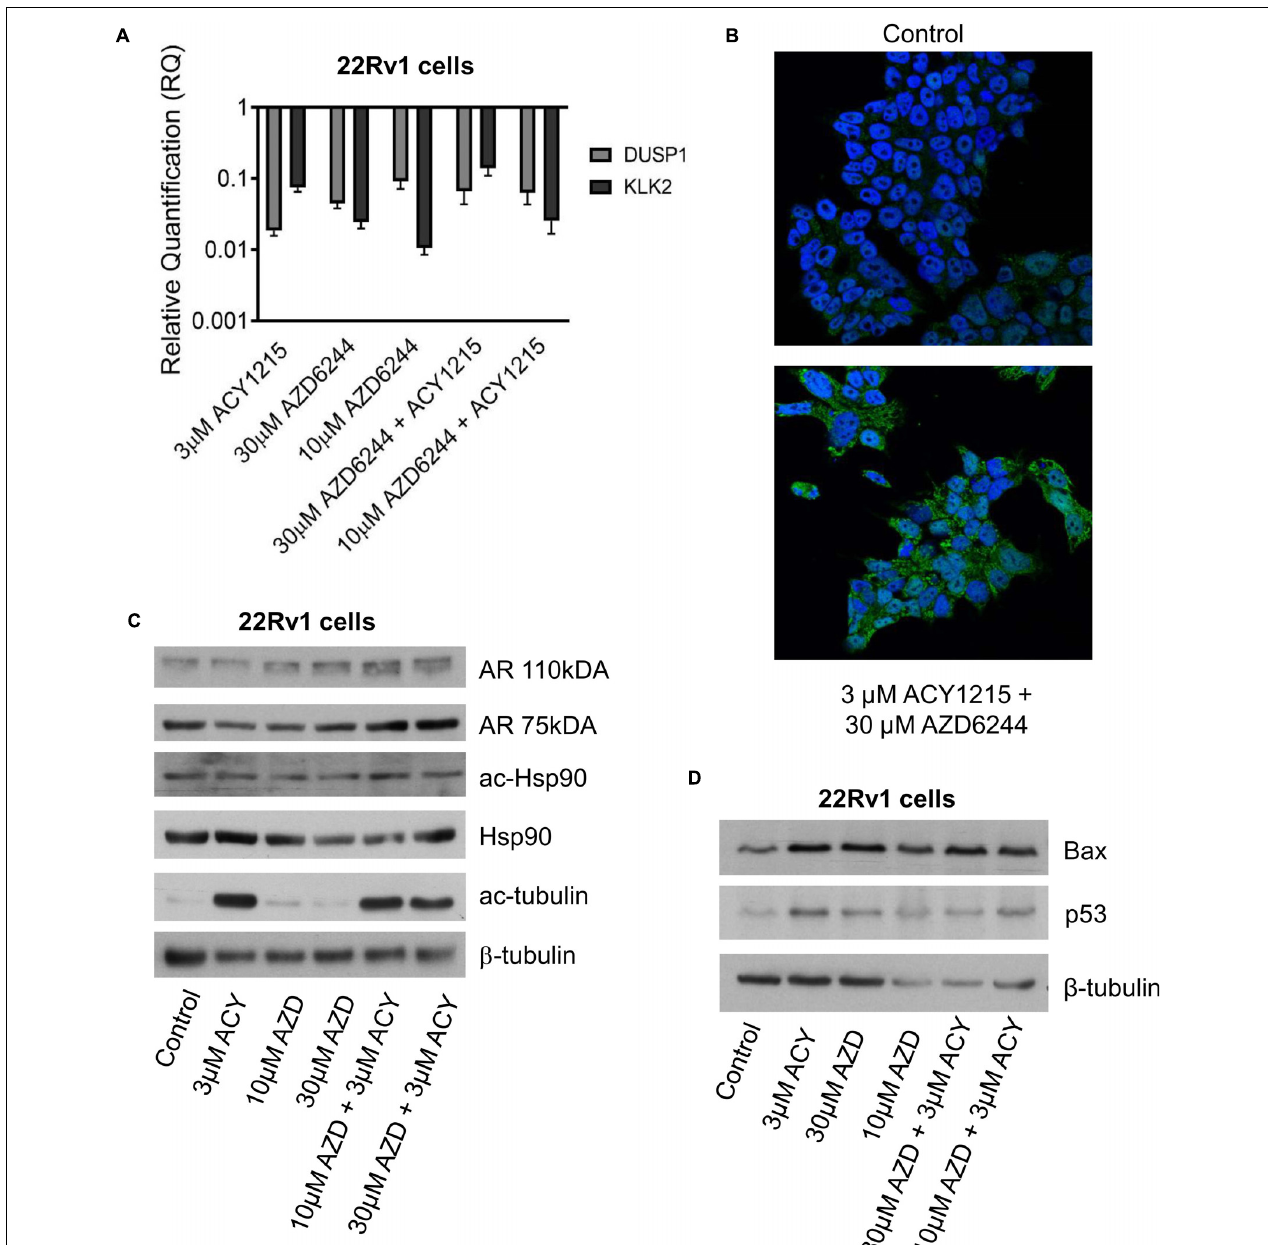
FIGURE 3 | Analysis of target modulation in 22Rv1 cells exposed to the combination of AZD6244 and ACY1215. Quantitative RT-PCR of AR target genes (KLK2 and DUSP1) was carried out in 22Rv1 cells incubated with AZD6244 and ACY1215 or their combination, according 24 h pre-treatment with ACY1215 followed by 48 h co-incubation with AZD6244. Control cells were used as calibrator and GAPDH as housekeeping gene (A) . Representative image of immunofluorescence analysis by confocal microscopy of AR localization in 22Rv1 treated cells according to 24 h pre-treatment with ACY1215 followed by 24 h co-incubation with AZD6244 (B) . Western blot analysis of possible targets was carried out in 22Rv1 cells incubated with AZD6244 and ACY1215 or their combination, according 24 h pre-treatment with ACY1215 followed by 24 h co-incubation with AZD6244. Control loading is shown by β -tubulin. The protein band intensity was quantified using ImageJ, normalized to that of the loading control and expressed relative to the level of control cells (set to 1). Normalized values corresponding to 3 µ M ACY1215, 10 µ M AZD6244, 30 µ M AZD6244, 10 µ M AZD6244 plus 3 µ M ACY1215, 30 µ M AZD6244 plus 3 µ M ACY1215 were 0.74, 1.11, 1.63, 1.96, 1.46 for AR 110 kDa; 0.58, 0.62, 0.96, 1.26, 1.25 for AR 75 kDa; 0.72, 0.67, 0.90, 1.10, 0.72 for ac-Hsp90; 1.08, 0.83, 0.57, 0.52, 0.83 for Hsp90; 21.61, 2.14, 2.36, 17.48, 15.19 for ac-tubulin, respectively (C) . Western blot analysis of apoptotic protein was carried out in 22Rv1 cells incubated with AZD6244 and ACY1215 or their combination, according 24 h pre-treatment with ACY1215 followed by 48 h co-incubation with AZD6244. Control loading is shown by β -tubulin. The protein band intensity was quantified using ImageJ, normalized to that of the loading control and expressed relative to the level of control cells (set to 1). Normalized values corresponding to 3 µ M ACY1215, 30 µ M AZD6244, 10 µ M AZD6244, 30 µ M AZD6244 plus 3 µ M ACY1215, 10 µ M AZD6244 plus 3 µ M ACY1215 were 2.41, 2.46, 4.57, 5.71, 4.13 for Bax; 3.37, 2.29, 4.16, 4.09, 4.54 for p53, respectively (D) .